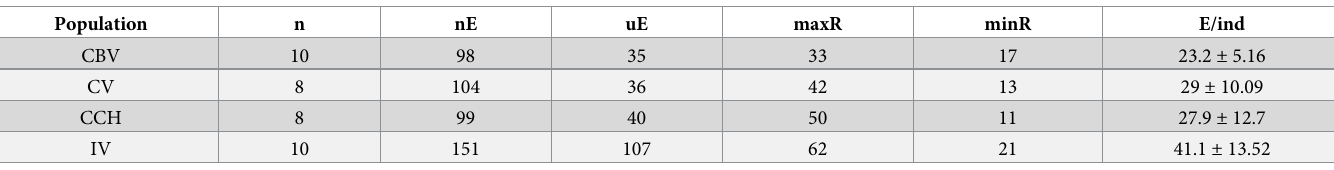
Table 1. Song elements recorded in four mountainous sites in Costa